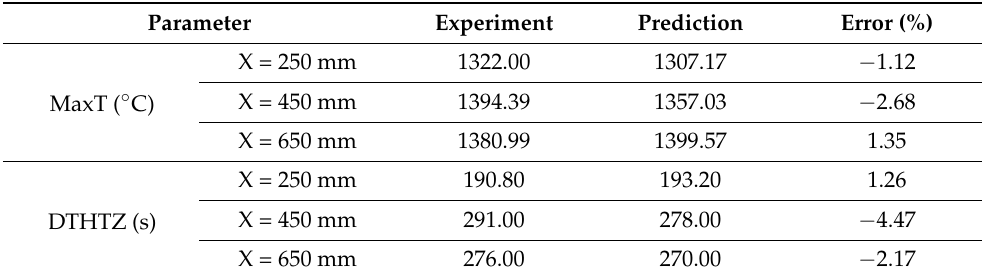
Table 5. The simulation and experiment of combustion characteristics parameters.